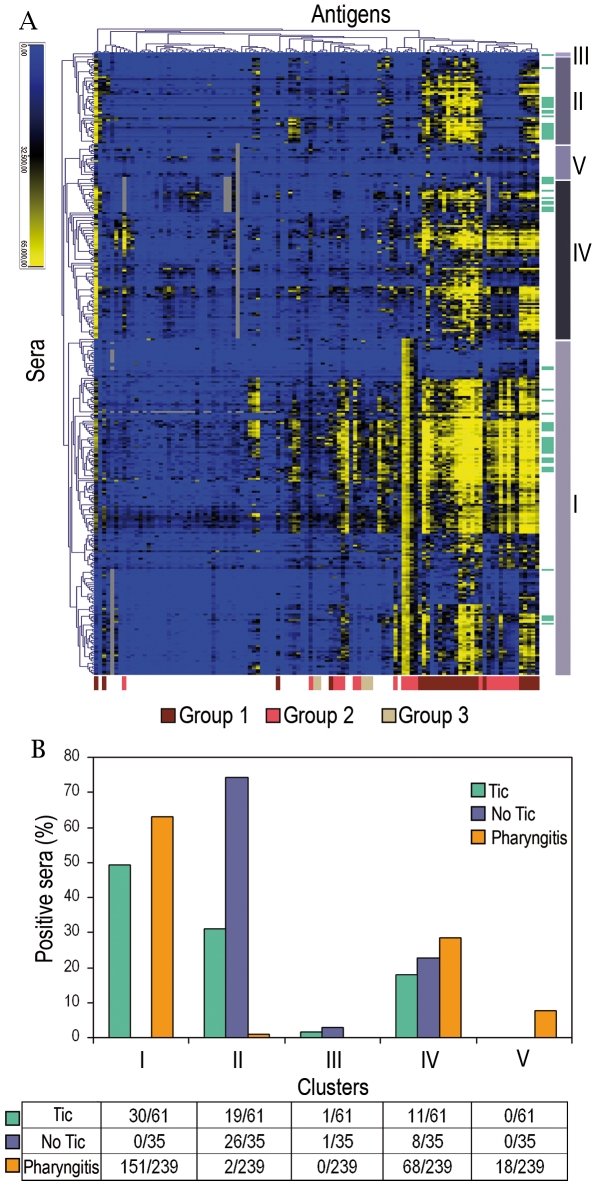
Tic, No Tic and Pharyngitis sera analysis.A, Unsupervised hierarchical clustering of human Tic (n = 61), No Tic (n = 35) and Pharyngitis (n = 239) sera versus the 102 selected GAS antigens. Antigens/sera interactions resulting in signals with high or low FI are visualized in yellow and blue respectively. Color scale of signal intensity is reported on top-left. Clusters group antigens and/or sera showing similar reactivity profiles. Bars and roman numbers on the right of the dendrogram identify the sera clusters considered for the analysis. Light green lines next to cluster bars highlight how the 61 tic sera distribute within the dendrogram. Colored bars at the bottom of the dendrogram highlight the distribution of group 1, group 2 and group 3 antigens, as defined in Tables I, II and III. B, Distribution of sera in the different clusters. The histogram shows the percent of positive sera (FI>15,000) for each class in relation to the five defined clusters. The number of positive sera in each cluster calculated on the total number of sera tested for each group is shown in the table below the histogram.